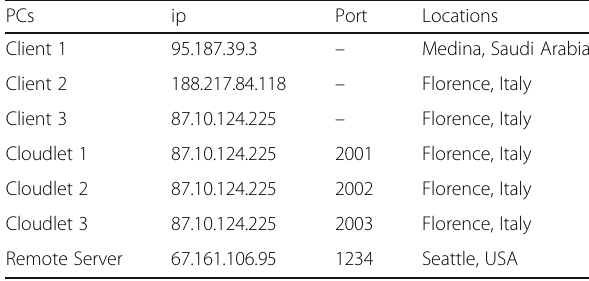
Table 1 Hardware used in the experiment PCs No.